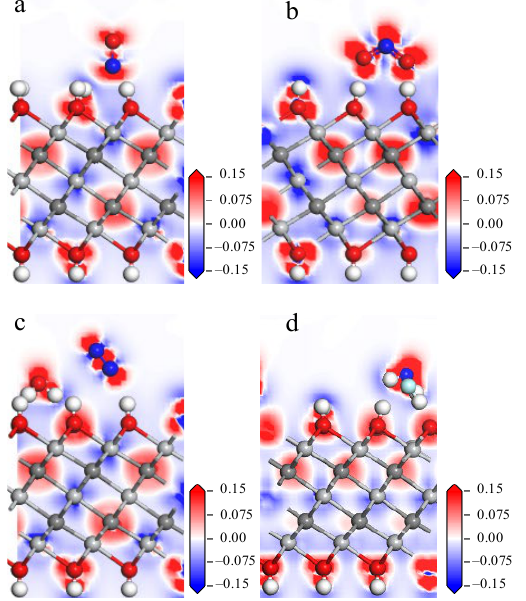
Figure 8. Deformation charge density diagram of ( a ) NO, ( b ) NO 2 , ( c ) N 2 O, ( d ) NF 3 on Ti 3 C 2 (OH) 2 surface. The TDOS of Ti 3 C 2 (OH) 2 after gas adsorption is shown in Figure 9. Apparently, the density of states of the whole system before and after the adsorption of NO, NO 2 , N 2 O, and NF 3 experiences a great change. It can be clearly seen that all the TDOS show a right shift, and the electronic states of the system move to higher energy levels after the adsorp- tion of these gases, indicating that the adsorption of the gases has a relatively large effect on the adsorption system, and the densities of states all increase around the Fermi energy level, meaning that the conductivity of the material is enhanced. All these changes are consistent with the large charge transfer between the gases and Ti 3 C 2 (OH) 2 . In addition, after the adsorption of NF 3 , a new peak at − 4.5 eV clearly appears, which changes the whole system the most, which also reflects the strongest interaction of NF 3 with Ti 3 C 2 (OH) 2 .